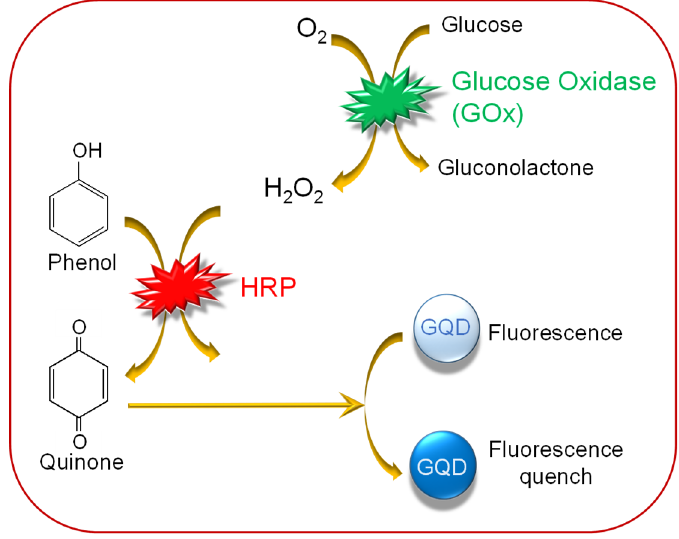
Figure 4. Detection mechanism of an enzyme based glucose-sensor. Adapted from Wang et al. [114].